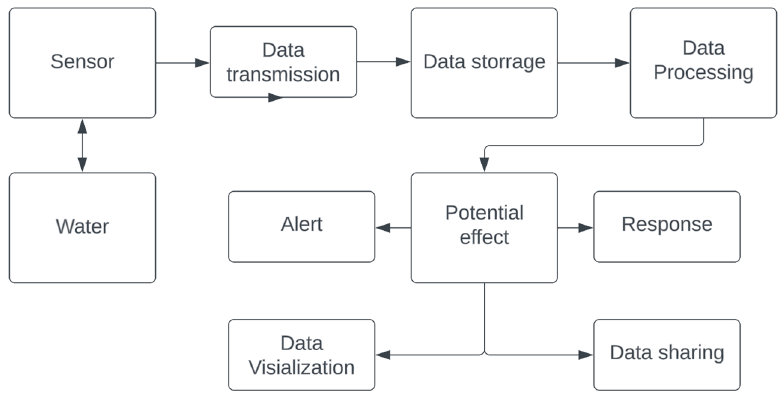
Figure 1. Example of an IoT system (a concept by the authors).